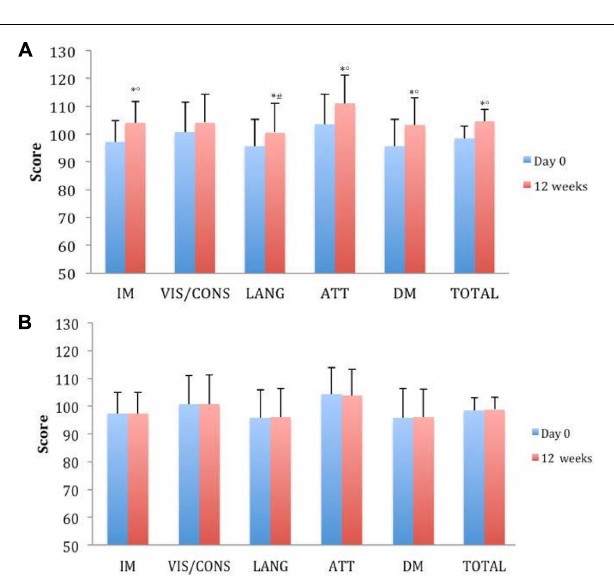
FIGURE 3 | Effects of Cognigrape (A) or placebo supplementation (B) for 12 weeks on Repeatable Battery for the Assessment of Neuropsychological Status (RBANS) in healthy older subjects. IM, immediate memory; VIS/CONS, visuospatial/constructional abilities; LANG, language; ATT, attention; DM, delayed memory. ∗ p < 0.01 vs. Cognigrape (Day 0); ◦ p < 0.01 vs. Placebo (12 weeks); # p < 0.05 vs. Placebo (12